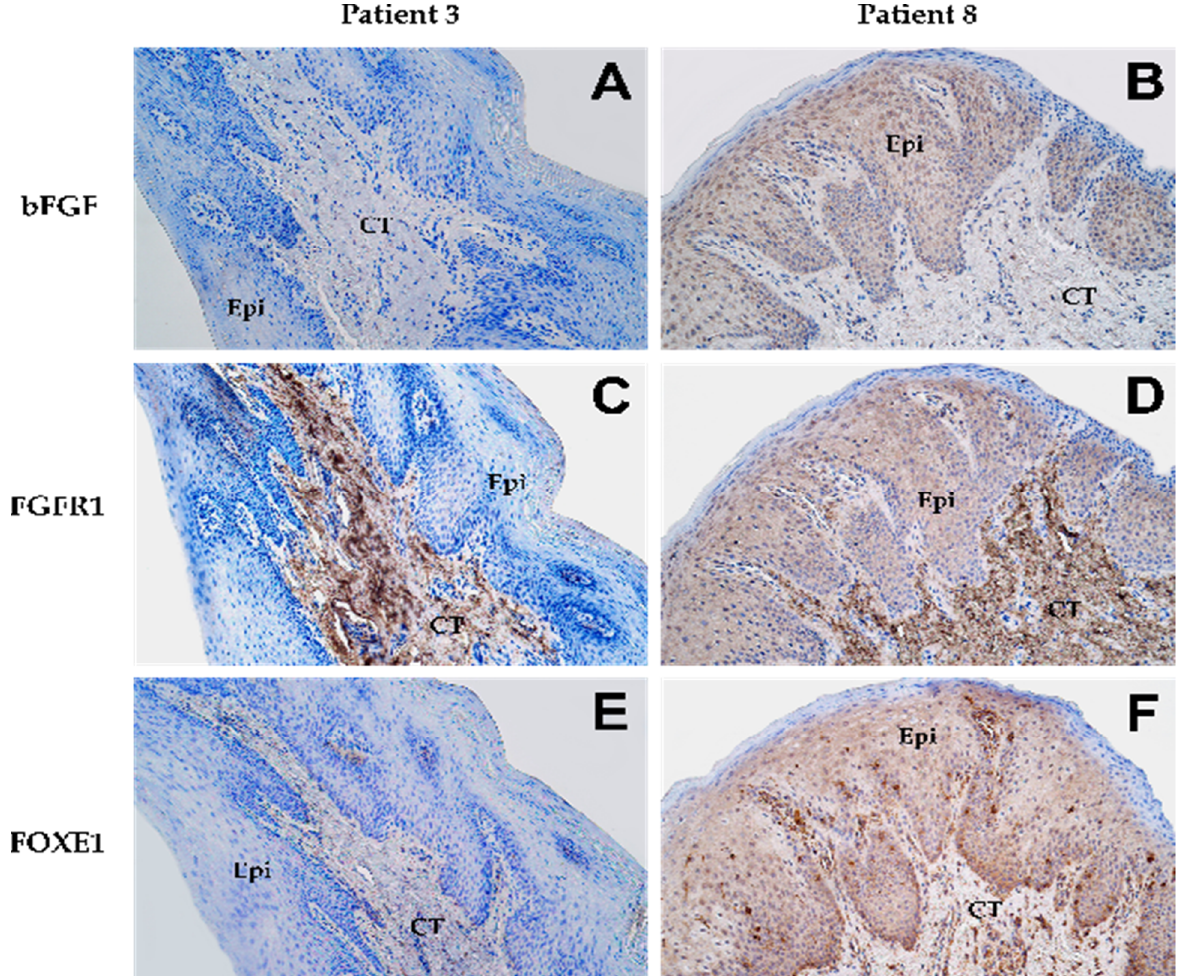
Figure 1. Expression patterns of various proteins as shown by immunohistochemical staining in lip mucosal tissue obtained from patient 3 ( A , C , E ) and patient 8 ( B , D , F ) at 200× magnification. “Epi” denotes epithelium while “CT” denotes connective tissue. Expression of bFGF in the epithelium shown by ( A ) none of the cells (0) and ( B ) a moderate number of cells (++). Connective tissue in both patients ( A , B ) showed no expression (0) of bFGF . Expression of FGFR1 in the epithelium shown by ( C ) none of the cells (0) and ( D ) a moderate number of cells (++). In connective tissue, both patients ( C , D ) presented numerous cells (+++) showing expression of FGFR1 . Expression of FOXE1 in the epithelium shown by ( E ) none of the cells (0) and ( F ) numerous cells (+++). However, in connective tissue, patient 3 ( E ) showed few positive cells (+) while patient 8 ( F ) showed numerous positive cells (+++) for FOXE1 . Table 3. Results by patient (semi-quantitative grading scale) for the IHC staining.